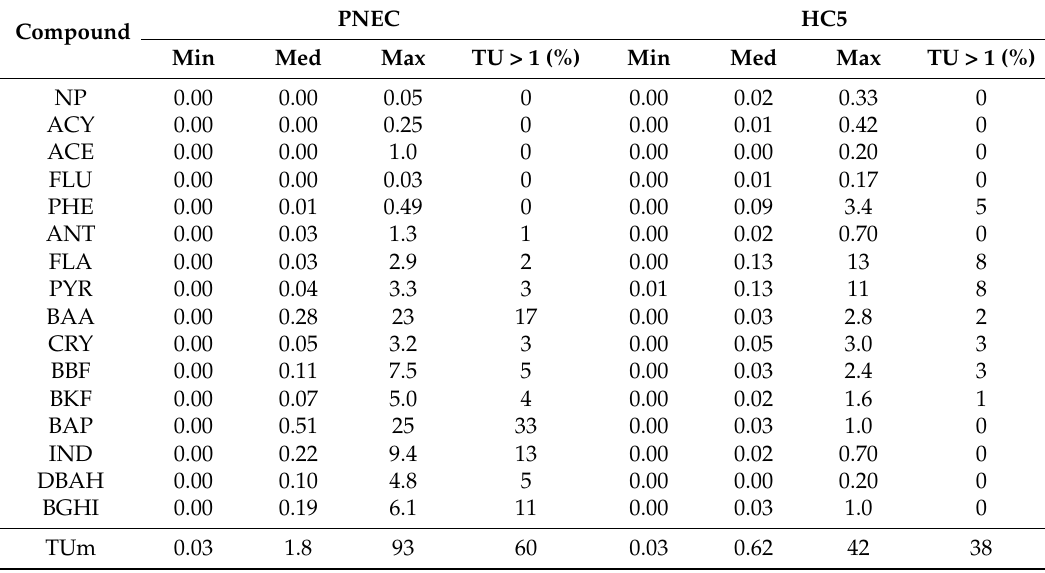
Table 3. Minimum, median, and maximum values of toxic units (TU) for individual compounds and toxic units of the mixture (TUm), using the predicted no effect concentration (PNEC) values and the hazard concentration (HC5) levels. Percentage of samples with TU and TUm above 1 is also shown. Compound